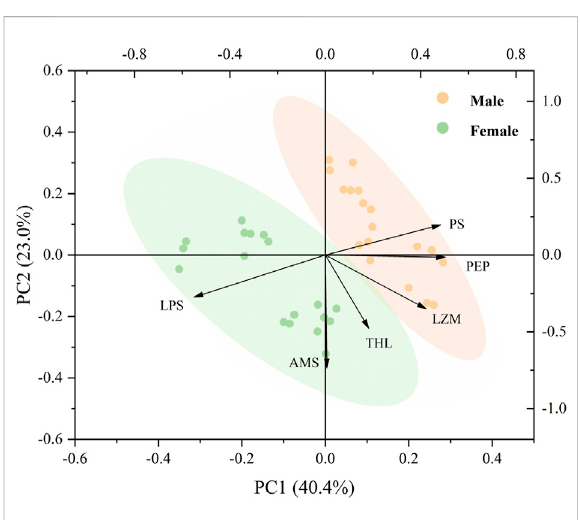
FIGURE 7 BiplotoriginatingfromPCAintegratingallmeasuredvariables (AMS, LPS, LZM, PEP, PS, and THL) and three temperature levels (20, 25, and 30 ° C) at six different treatments during the exposure